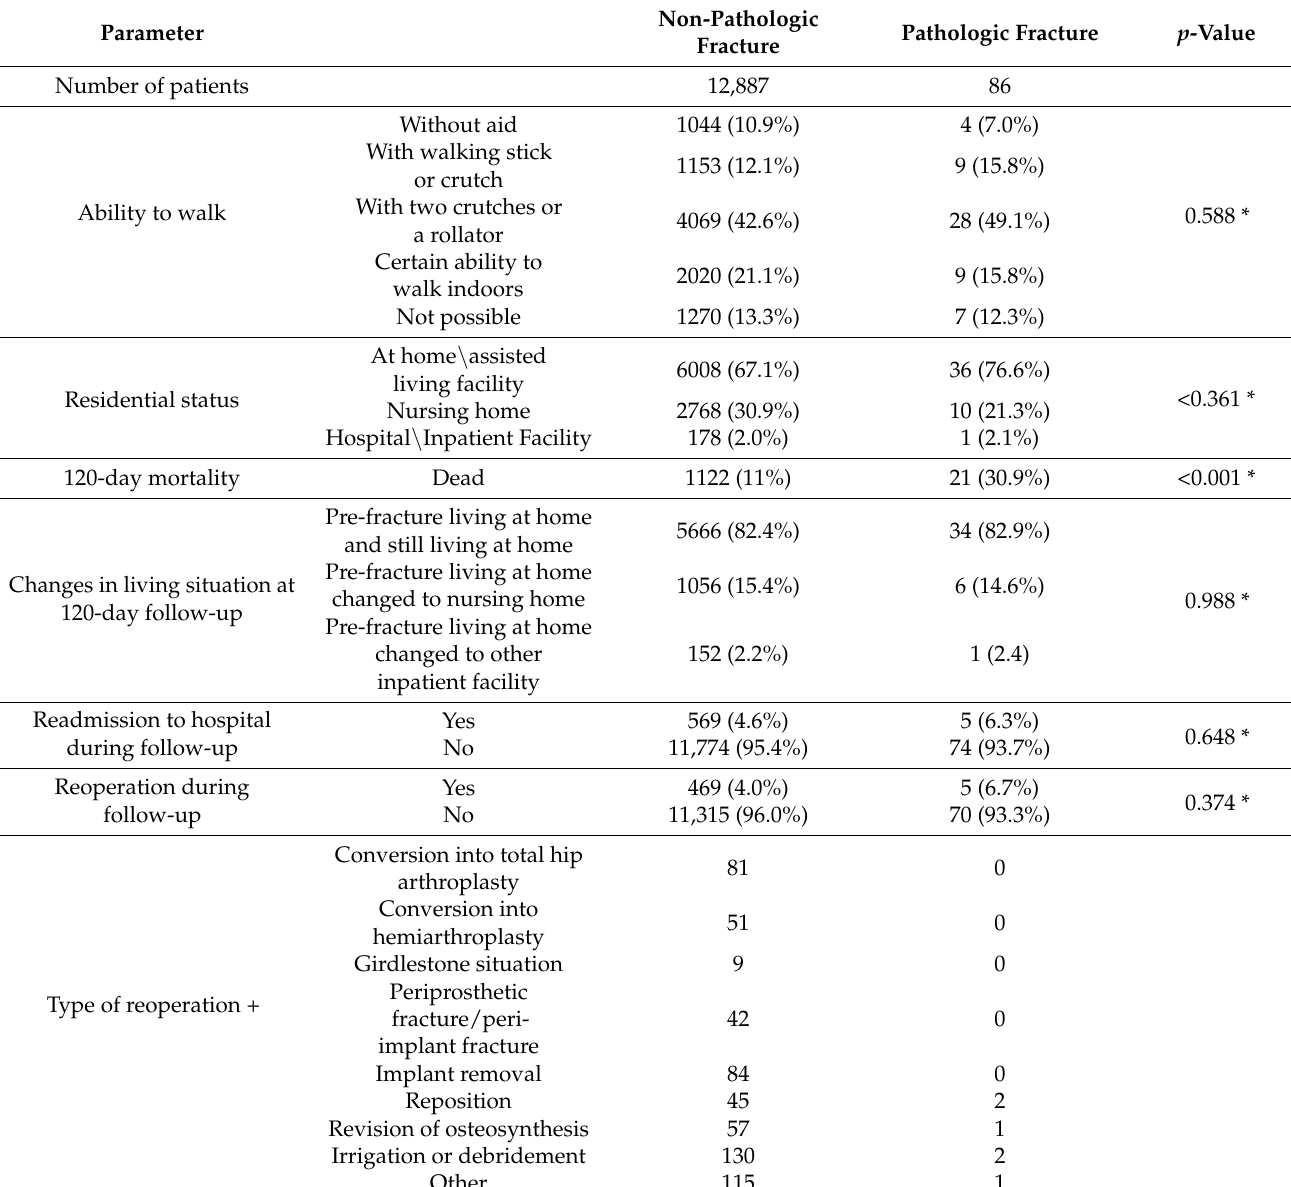
Table 4. Univariable analysis of 120-day follow-up data on geriatric trauma patients with hip fractures depending on the kind of fracture entity.